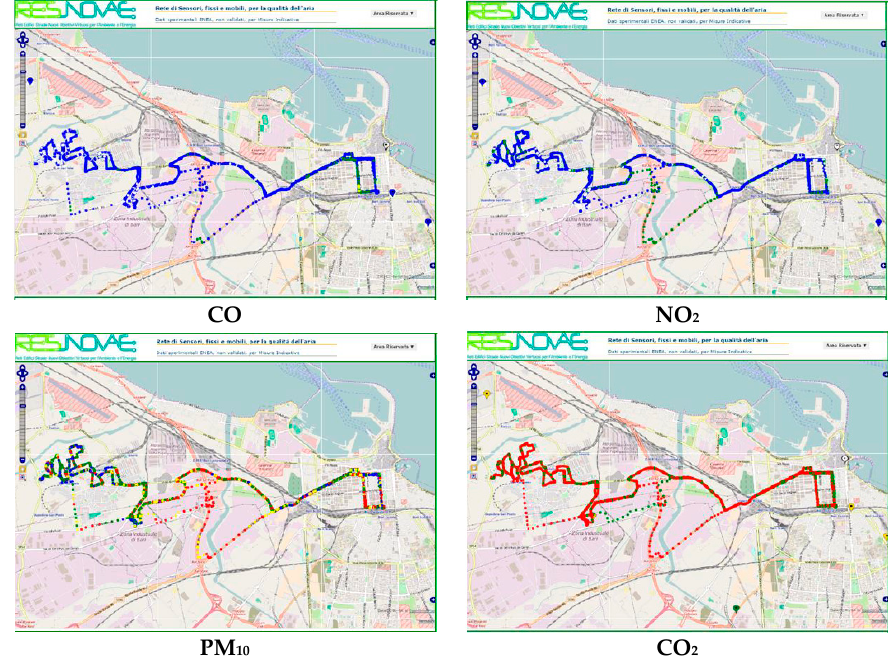
Figure 5. Typical CO, NO 2 , PM 10 and CO 2 air quality index (AQI) trend (1 min average on 9 November 2015) of the mobile sensor-node installed on the roof of a public bus (AMTAB) circulating in Bari